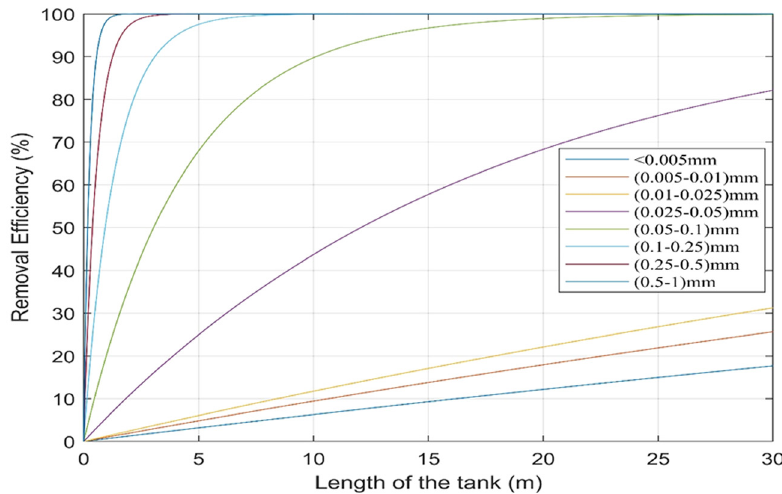
Figure 3: Removal e ffi ciency for each particle size with fl occulation process for coded model.